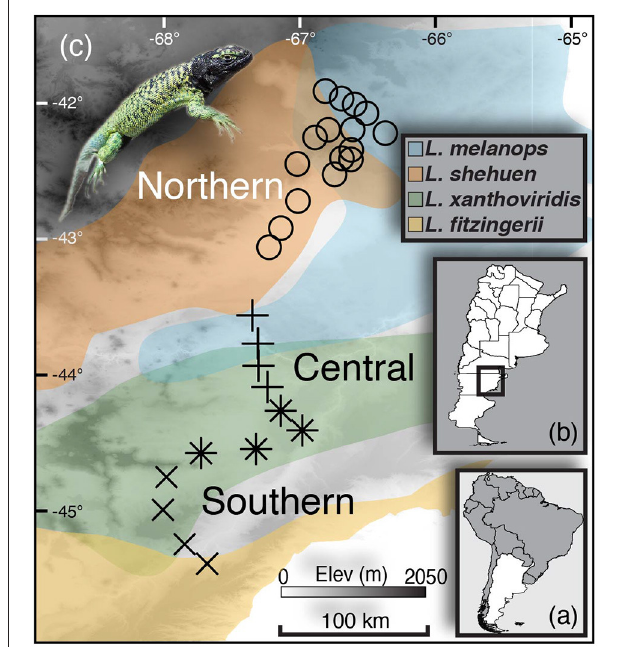
FIGURE 1 | Sampling map with insets showing (A) Argentina and (B) the provincial borders within Argentina and where the study took place (C) . Transect sampling localities for the Northern hybrid zone are shown as circles, whereas the “Central” and “Southern” transects are shown as + s and Xs, respectively (the localities marked with asterisks/stars were analysed in both Central and Southern transects). Colors on the map reflect population boundaries as determined by genome-wide SNP data in Grummer (2017) that largely correspond to the species Liolaemus melanops (blue), L. shehuen (orange), L. xanthoviridis (green), and L. fitzingerii